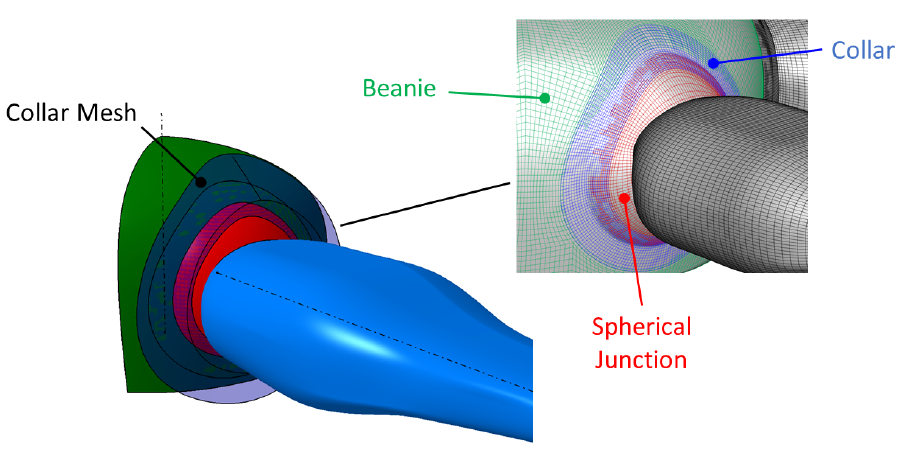
Figure 9. Definition of the collar mesh enabling a valid transition between the beanie and the rotor blade